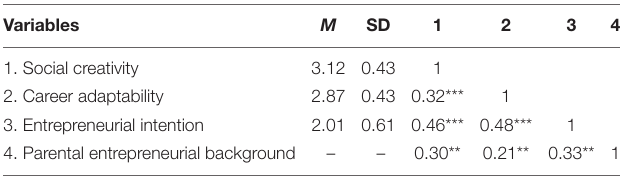
TABLE 1 | Descriptive statistics and correlations for